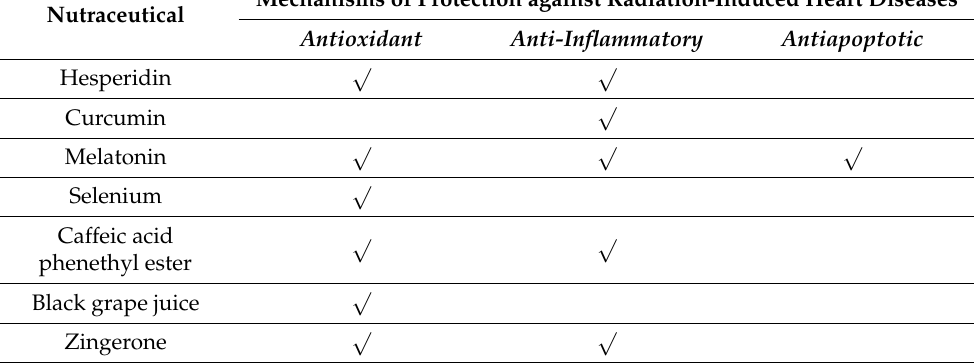
Table 7. Nutraceuticals and their mechanisms of protection against RIHD (Adapted from [225]).